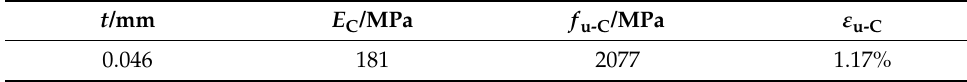
Table 5. Average values of the tensile mechanical properties of FRCM plates.